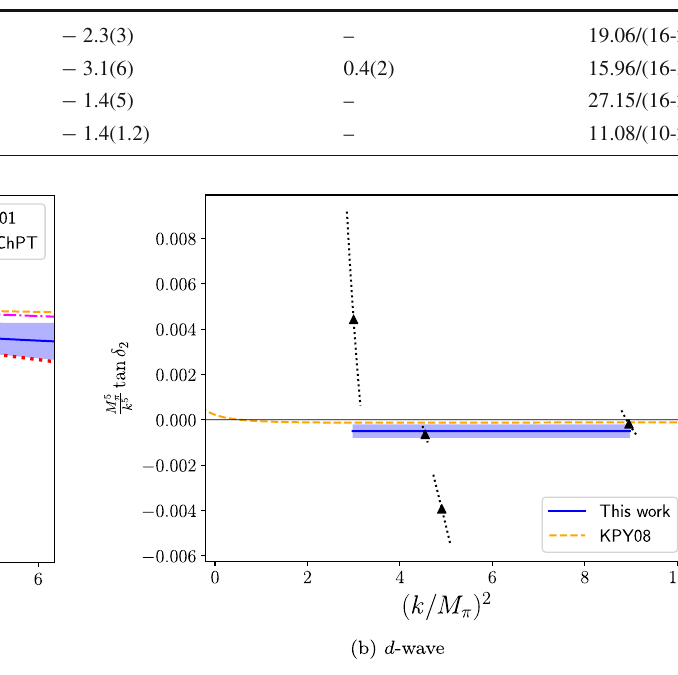
Fig. 2 s - and d -wave phase shift at the physical point (ensemble cA2.09.48) compared to the fits to experimental data (KPY08) in Ref. [92] and (CGL01) in [93]. For s -wave we use a model that incorporates